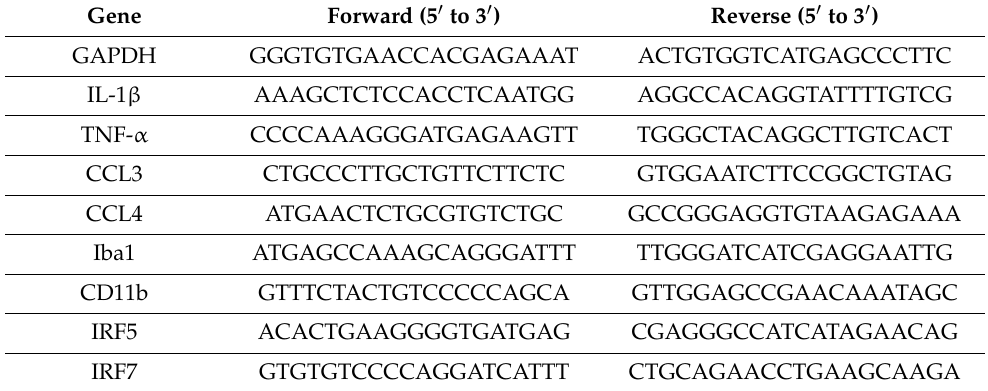
Primer sequences for reverse transcription-quantitative polymerase chain reaction